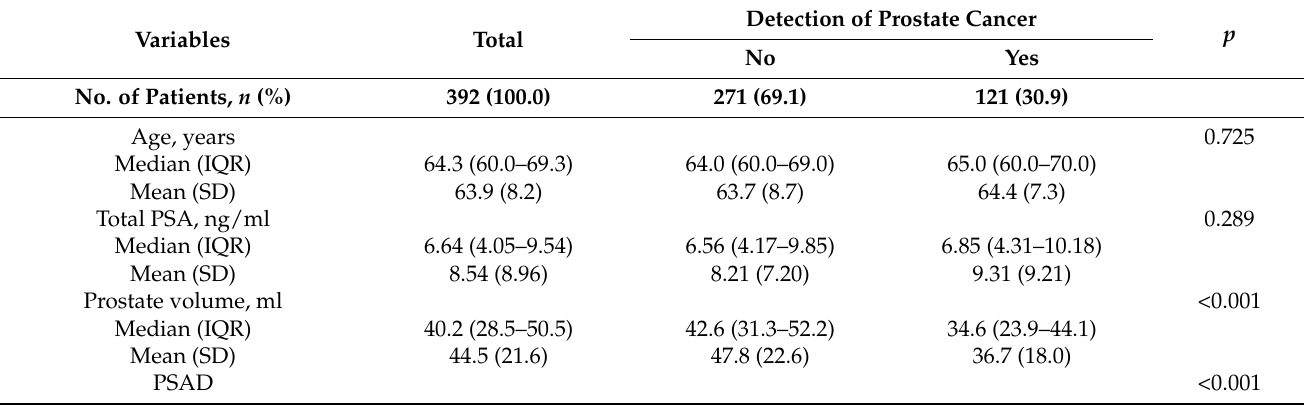
Table 1. Baseline